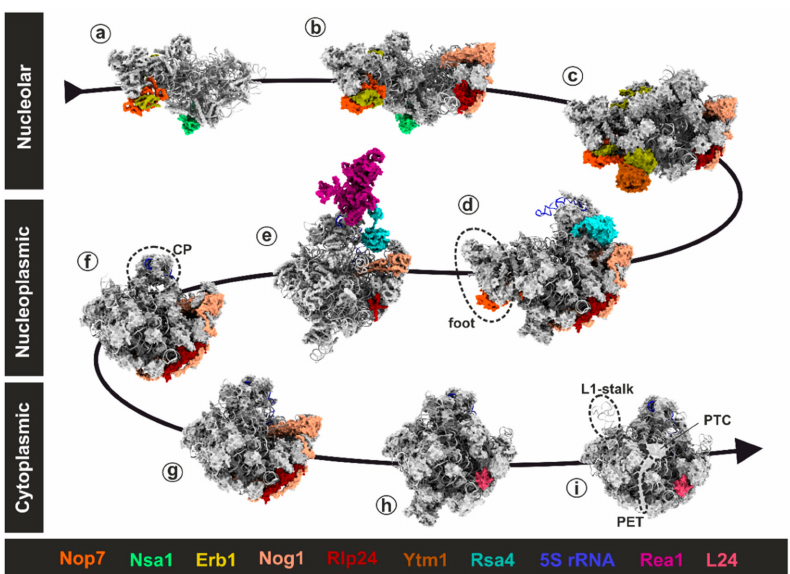
Figure 2. Transformation of pre-60S particles. Selected cryo-EM structures of yeast pre-60S particles highlight the structural and conformational transformation during the maturation cascade from the nucleolus to the cytoplasm. The rRNA undergoes manifold rearrangements, maturation factors (colored legend) temporarily associate with the pre-ribosomal particles, and the r-proteins are stepwise-incorporated. The characteristic foot structure is removed in the nucleoplasm and hallmark structures of the large subunit take on their final shape, including the central protuberance (CP), the polypeptide exit tunnel (PET), the peptidyl transferase center (PTC) and the L1 stalk. a–c: PDB ID 6EM3, 6EM1, and 6ELZ [31]. d: PDB ID 3JCT [33]. e: PDB ID 5JCS [27]. f–g: PDB ID 6N8J and 6N8K [35]. h–i: PDB ID 6RZZ and 6QT0